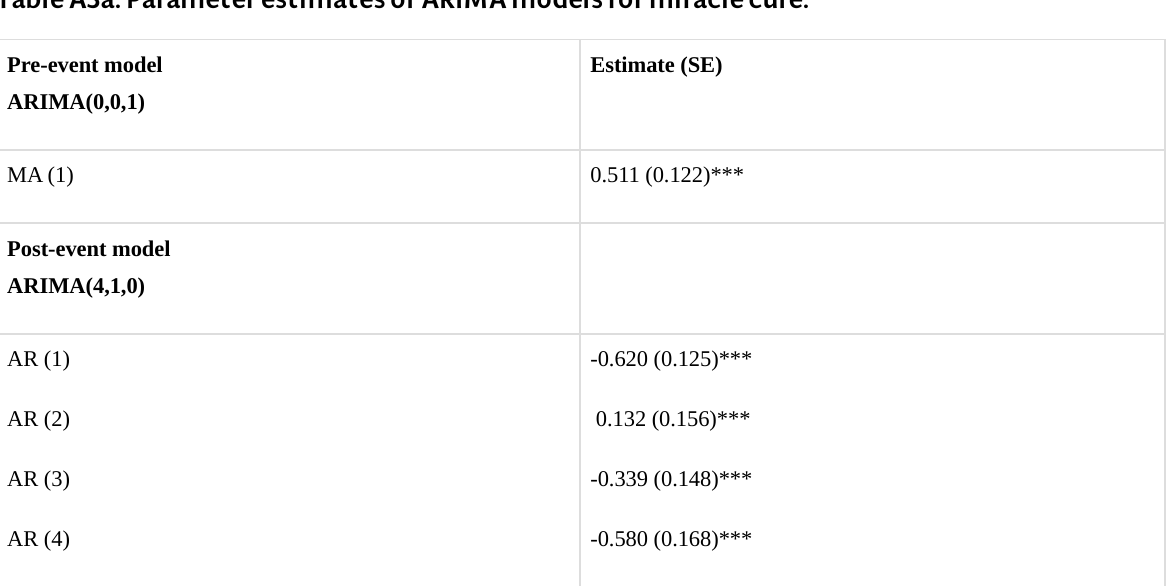
Table A3a. Parameter estimates of ARIMA models for miracle cure.